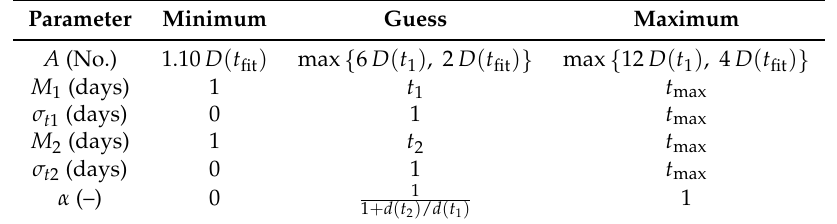
Table 1. lsqcurvefit range of fitting